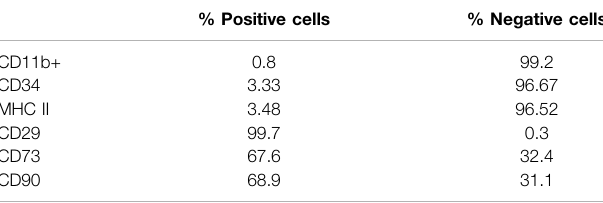
TABLE 1 | Characterization of mesenchymal stem cells by fl ow cytometry. % Positive